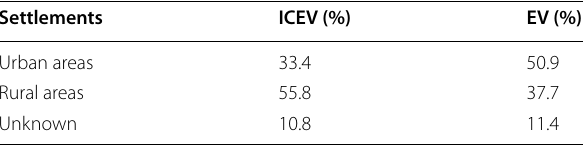
Table 6 Distributions of crashes by roadway surface conditions